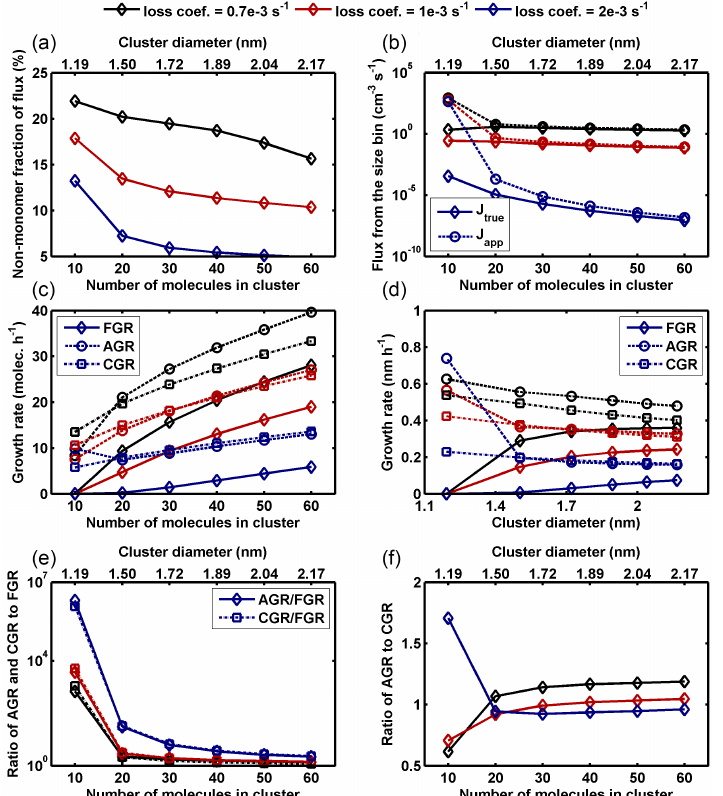
Figure A3. The effect of loss coefficient (shown as different colors) on quantities describing cluster growth: (a) the non-monomer fraction of flux from each size bin; (b) the true collision–evaporation flux from each size bin ( J true ; solid line) and the fluxes calculated from the appearance times of clusters ( J app ; dashed line); (c, d) the flux-equivalent growth rate (FGR; solid line), the growth rate derived from the appearance times of clusters (AGR; dashed line), and the growth rate calculated based on irreversible vapor condensation (CGR; dotted line); (e) the ratios of AGR to FGR (solid line) and CGR to FGR (dotted line); (f) the ratio of AGR to CGR.